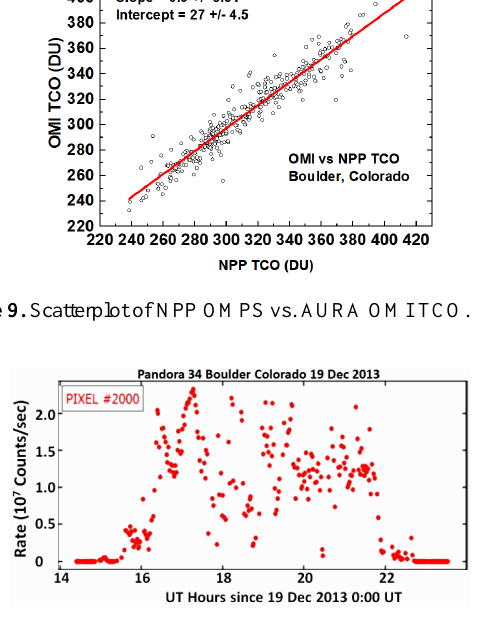
Figure 10. Pixel 2000 (about 520nm) in counts per second vs. time of day (UT) for a cloudy day (Thursday, 19 December